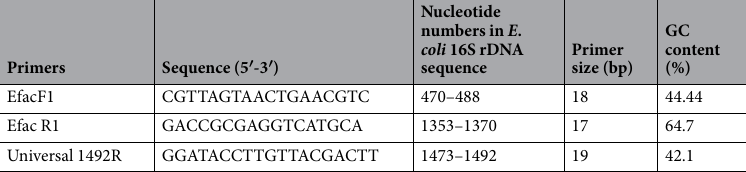
Table 6. Sequences, size and GC contents of primers used for PCR